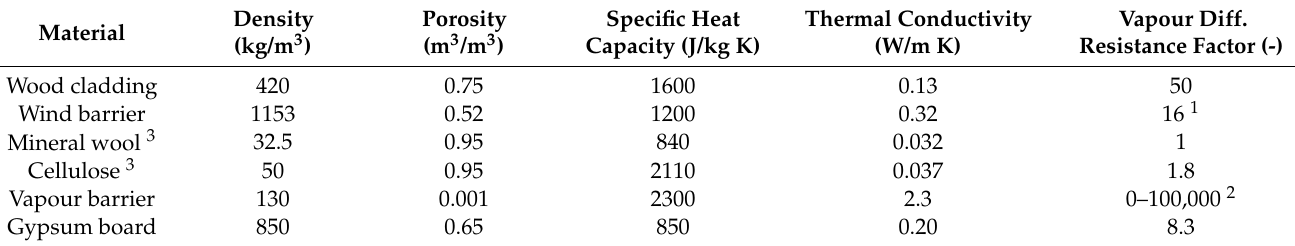
Table 1. Material properties for the reference model.